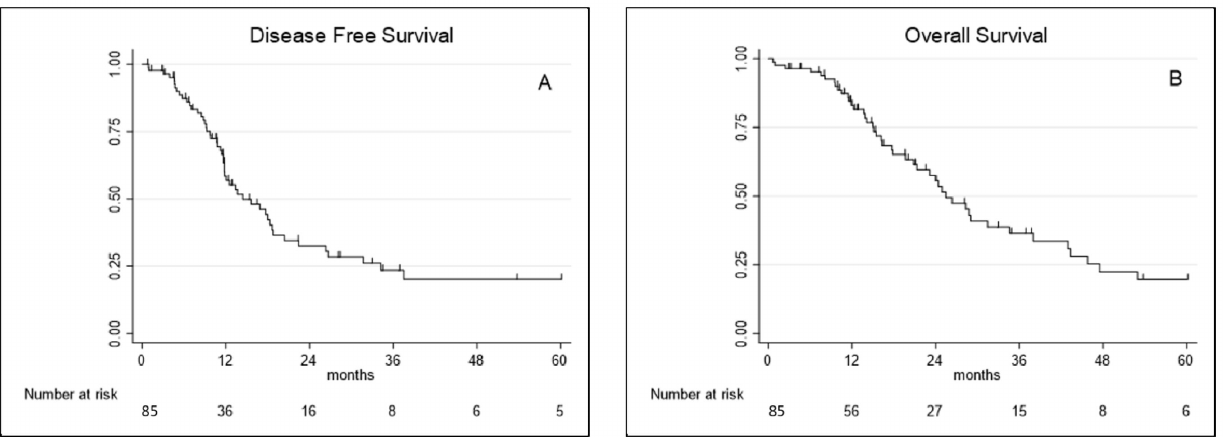
Figure 1. ( A ) Disease-free survival and ( B ) overall survival curves for extended pleurectomy decortication (eP/D). All clinical and biological characteristics investigated in cox regression analysis of DFS and OS are reported, respectively, in Tables 3 and 4. Table 3. Details of the statistical analysis: univariate and multivariate analyses—disease-free survival (Cox proportional hazards model). DFS Univariable Multivariable Variable